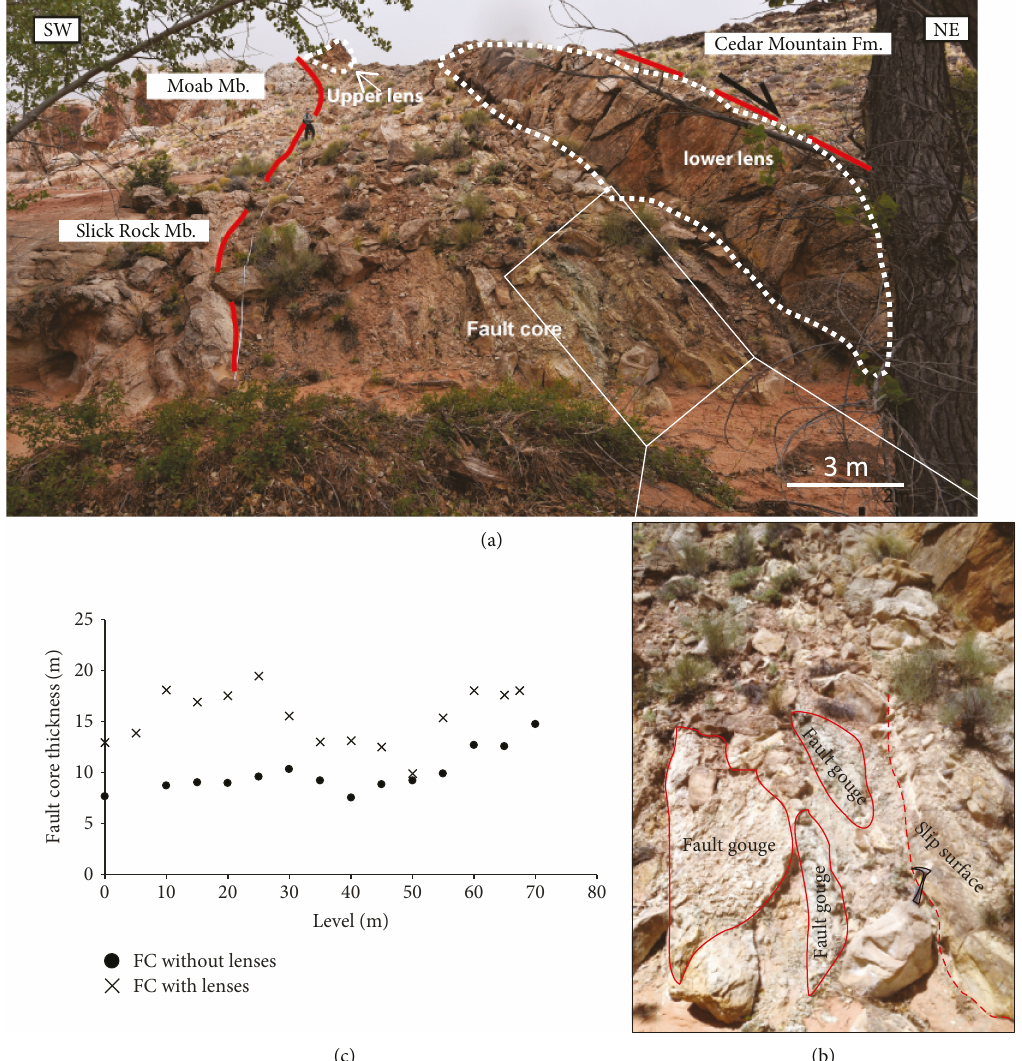
Figure 5: (a) Outcrop photo of the Bartlett Fault at the Hidden Canyon locality in Utah, which has displaced rocks of the Cedar Mountain Formation (hanging wall) against Slick Rock and Moab Members (footwall). (b) A closeup of the fault core showing several fault gouges and a major slip surface. (c) Fault core thickness (FC) measurements at the Hidden Canyon with and without including the lens